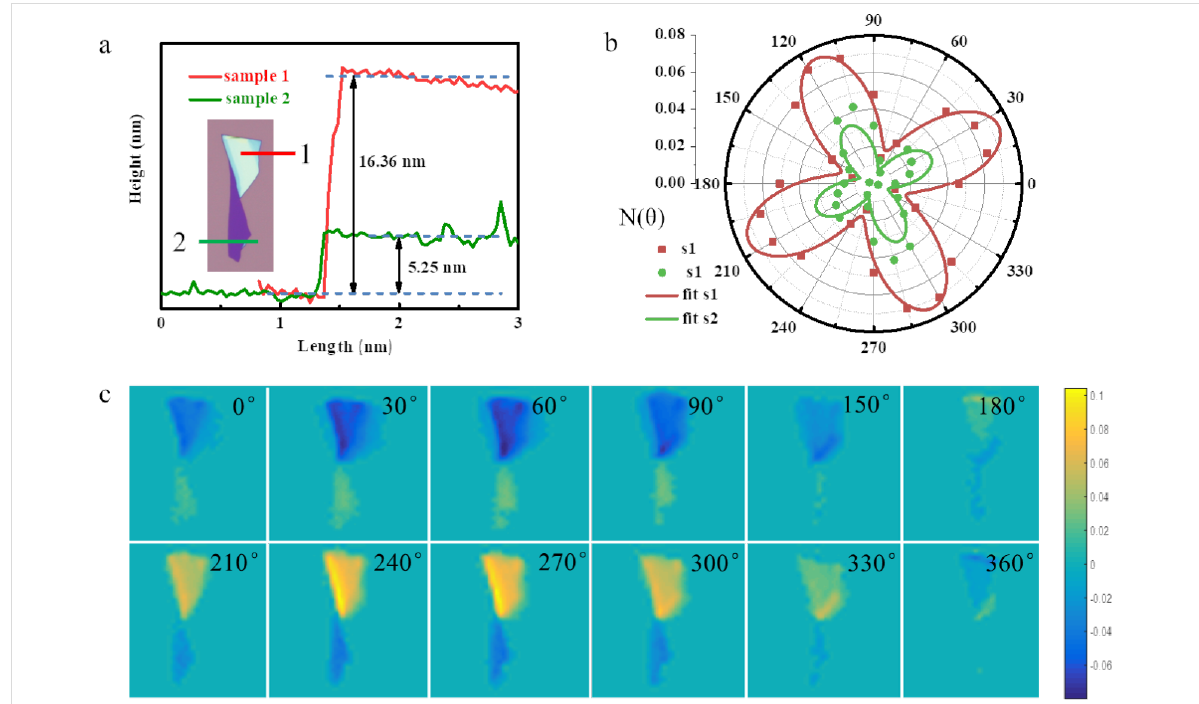
Figure 2: Identification of the lattice anisotropy of an exfoliated 1T’-WTe 2 flake. a) AFM image of the 1T’-WTe 2 flake transferred onto a Si/SiO 2 sub- strate by mechanical exfoliation. The heights of zone 1 and zone 2 are 16.36 nm and 5.25 nm, respectively. b) ADRDM results of the same WTe 2 flake (Figure 1a) in polar coordinates. c) Azimuth-dependent RDM images.